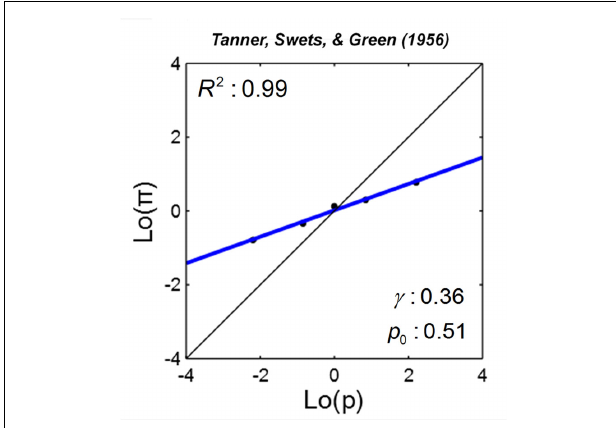
FIGURE 7 | Linear in log odds fit: signal detection theory. Estimated probability of signal present is plotted against the true probability on log odds scales for one participant. Black dots denote data.The blue line denotes the LLO fit. R 2 denotes the proportion of variance accounted by the fit. InTanner et al. (1956), c.f. Green and Swets (1966/1974), participants were asked to report whether a sound signal was present or absent. Estimated probability was inferred from the participant’s decision criterion based on signal detection theory. Data are fromTable 4-1 of Green and Swets